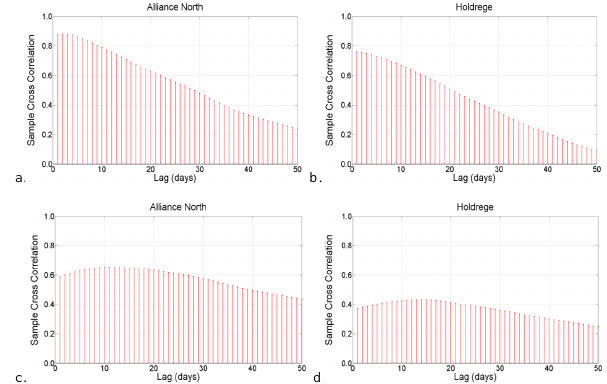
d. Figure 4 . Sample cross correlations at two Oklahoma stations: (4a) and (4c) show 5-25 cm and Figure 5 . Sample cross correlations at two Nebraska stations: (4a) and (4c) show 10-25 cm and 5-60 cm cross correlations at Durant, Oklahoma and (4b) and (4d) show 5-25 cm and 5-60 cm Fig. 5. Sample cross correlations at two Nebraska stations: (a) and 10-50 cm cross correlations at Alliance North, Nebraska and (4b) and (4d) show 10-25 cm and cross correlations at Miami, Oklahoma. Fig. 4. Sample cross correlations at two Oklahoma stations: (a) and (c) show 10–25cm and 10–50cm cross correlations at Alliance 10-50 cm cross correlations at Holdrege, Nebraska. (c) show 5–25cm and 5–60cm cross correlations at Durant, Okla- North, Nebraska and (b) and (d) show 10–25cm and 10–50cm homa and (b) and (d) show 5–25cm and 5–60cm cross correlations cross correlations at Holdrege, at Miami, Oklahoma.